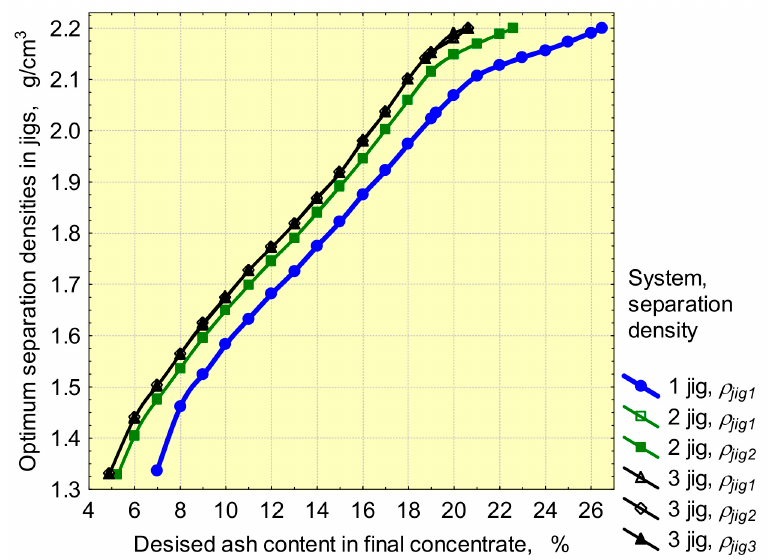
Figure 9. Optimum separation density in one jig ( 1 os. ) and systems with re-enrichment of intermedi- ate concentrate ( two-jig and three-jig ).